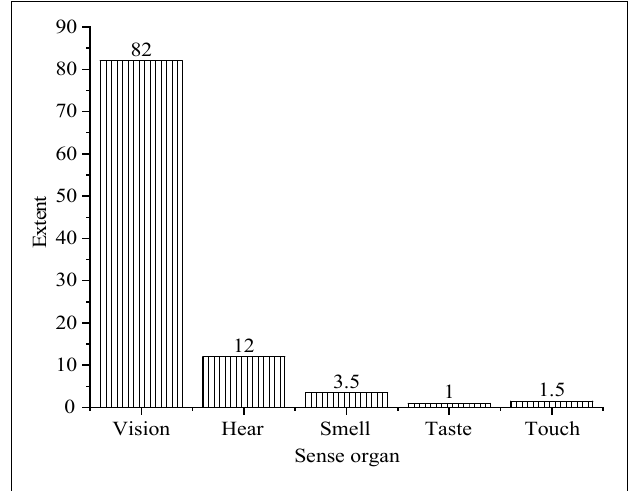
FIGURE 3 | The information acceptance degree of different senses (data comes from accenture: